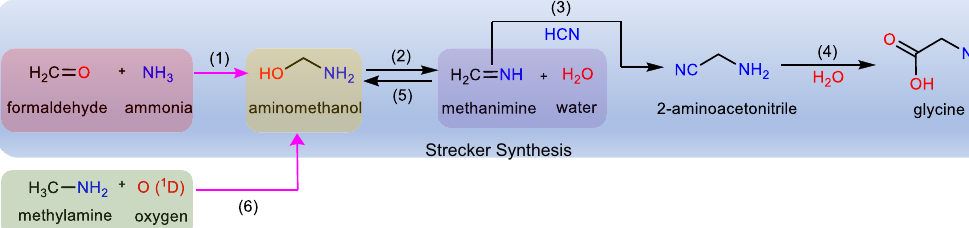
Fig. 1 Strecker synthesis of glycine. A simpli fi ed view of the reaction steps (1 – 4) involved in the Strecker Synthesis of glycine. Pink arrows indicate the proposed laboratory synthetic route (1, 6) to